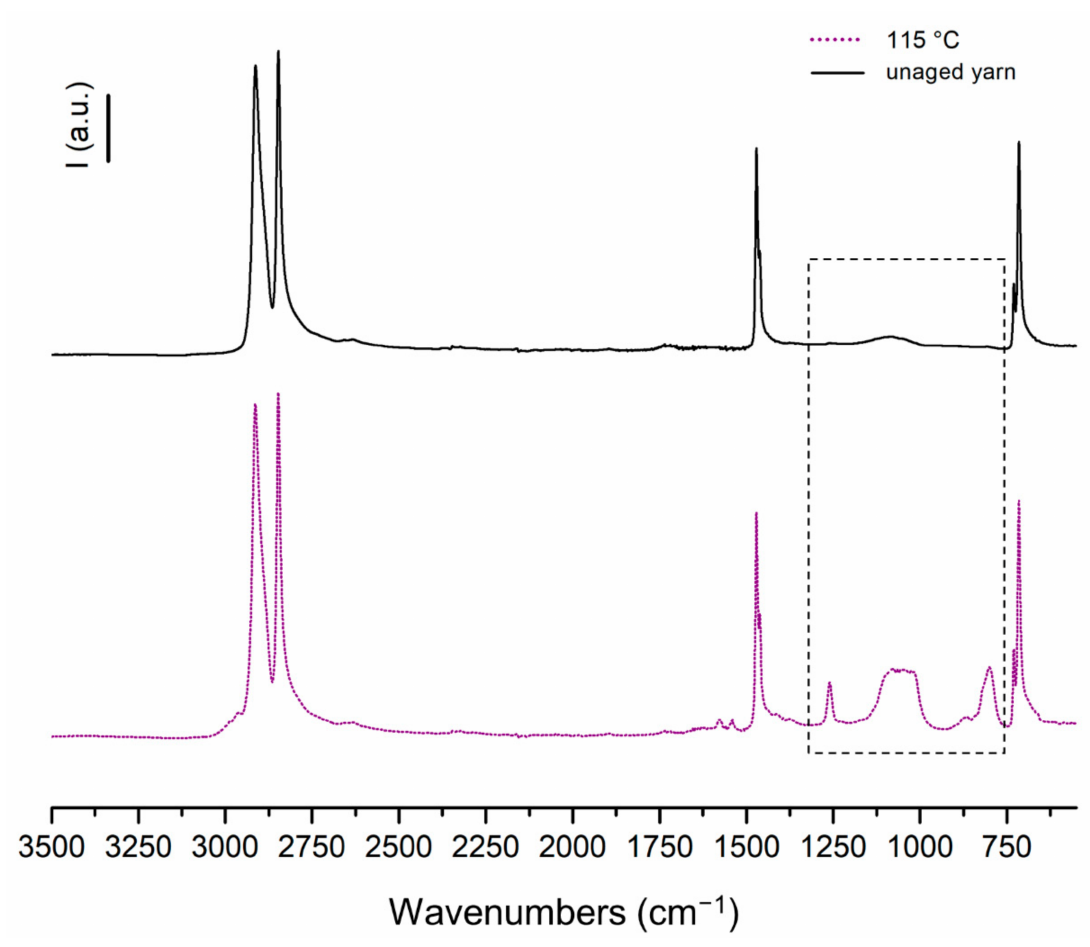
Figure 6. FTIR spectra of control unaged and thermally aged UHMMPE fibers at 115 ◦ C in air; marked area highlights changes in the spectra after thermal aging due to presence of newly formed vinyl, trans-vinylene, alcohol, and ester